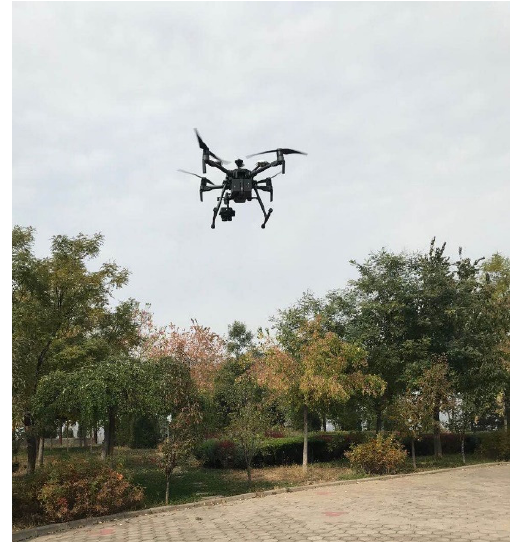
Figure 2. Photos of UAV operation.